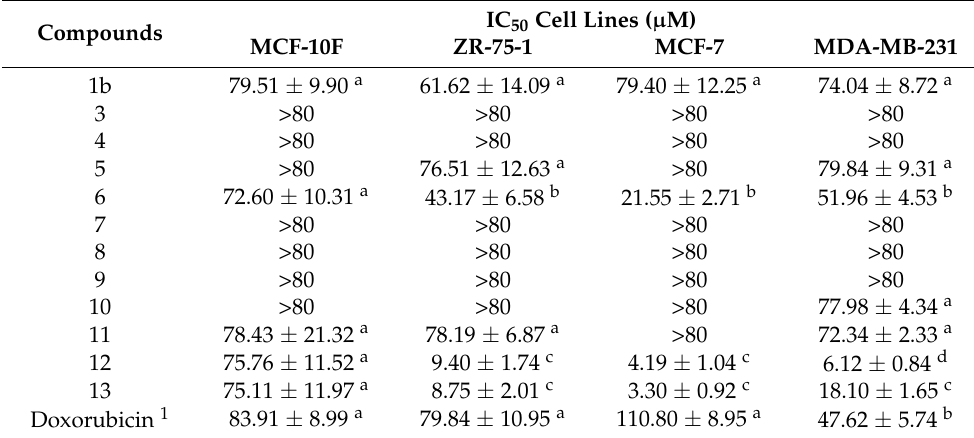
Table 2. IC 50 of synthesized chalcones in different lines of breast